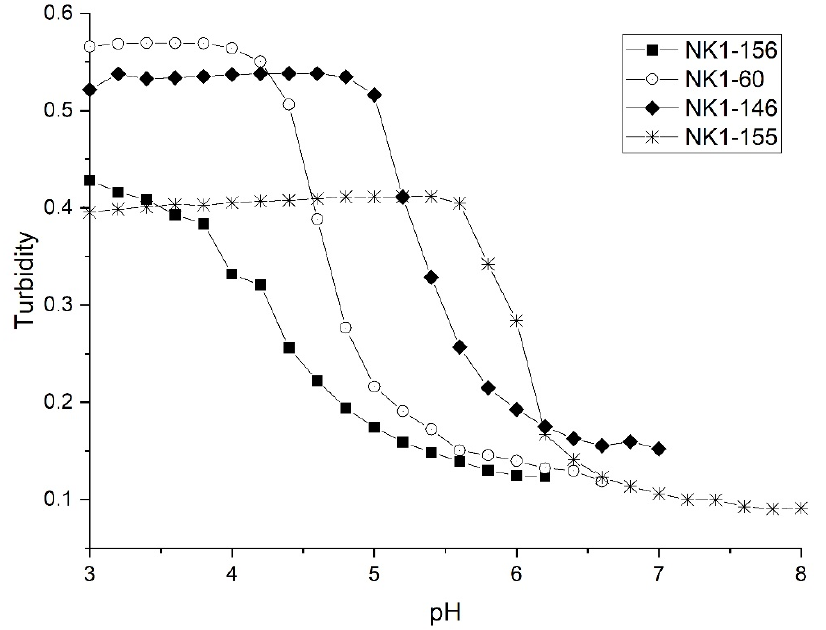
Figure 8. pH response profiles of four poly ( N -isopropylacrylamides) synthates prepared by copoly- merization of NIPA with AA (NK1-156), MAA (NK1-60), EAA (NK1-146), and PAA (NK1-155).